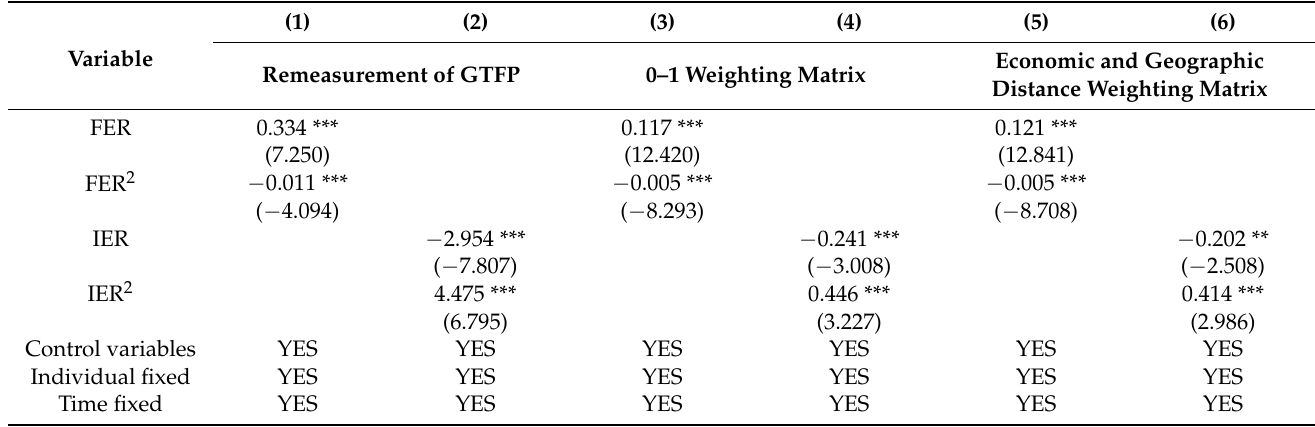
Table 8. Robustness